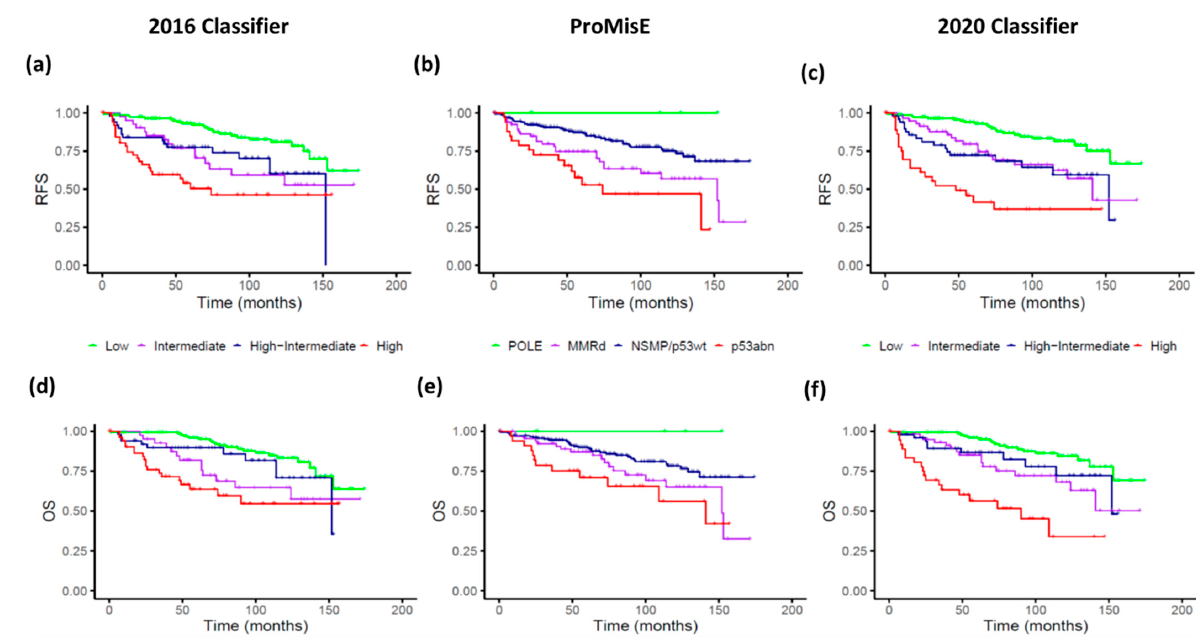
Figure 1. Relapse-free survival (RFS) and overall survival (OS) curves estimation by stratification prognosis tools. Upper row illustrates RFS for the 2016 Classifier ( a ), ProMisE ( b ), and 2020 Classifier ( c ). Lower row illustrates OS for the 2016 Classifier ( d ), ProMisE ( e ), and 2020 Classifier ( f ). The 2016 Classifier refers to the ESMO-ESGO-ESTRO classification, ProMisE to the Proactive Molecular Risk Classifier for Endometrial Cancer, and the 2020 Classifier to ESGO-ESTRO-ESP. The distribution of prognosis risk groups, 5-year survival rate, Cox regression and c-index analysis for each classifier are detailed in Table 2. Table 2. Risk stratification tools accuracy comparison by relapse-free survival.